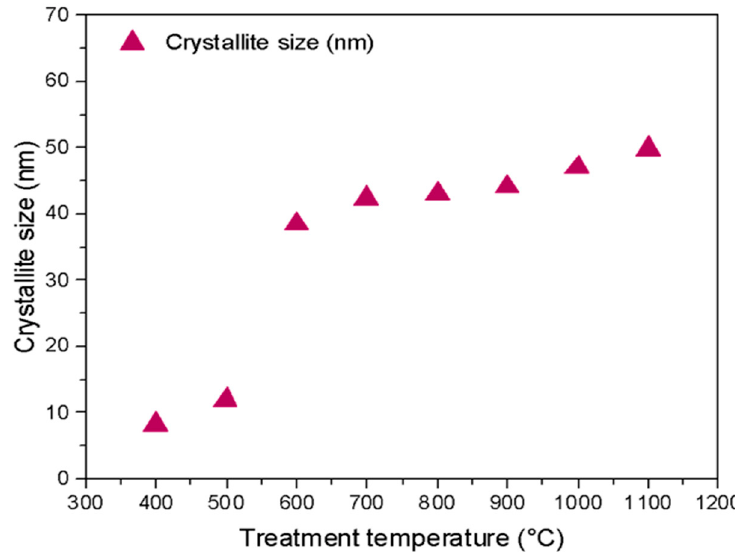
Figure 3. The crystallite size of CuFe 2 O 4 heat-treated at different temperatures.